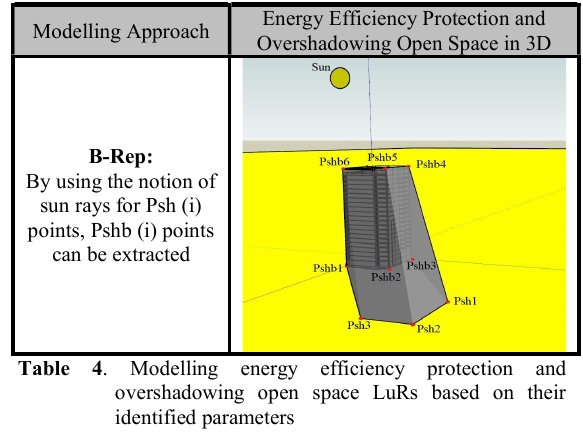
Figure 3 . Modelling overlooking regulation using CSG